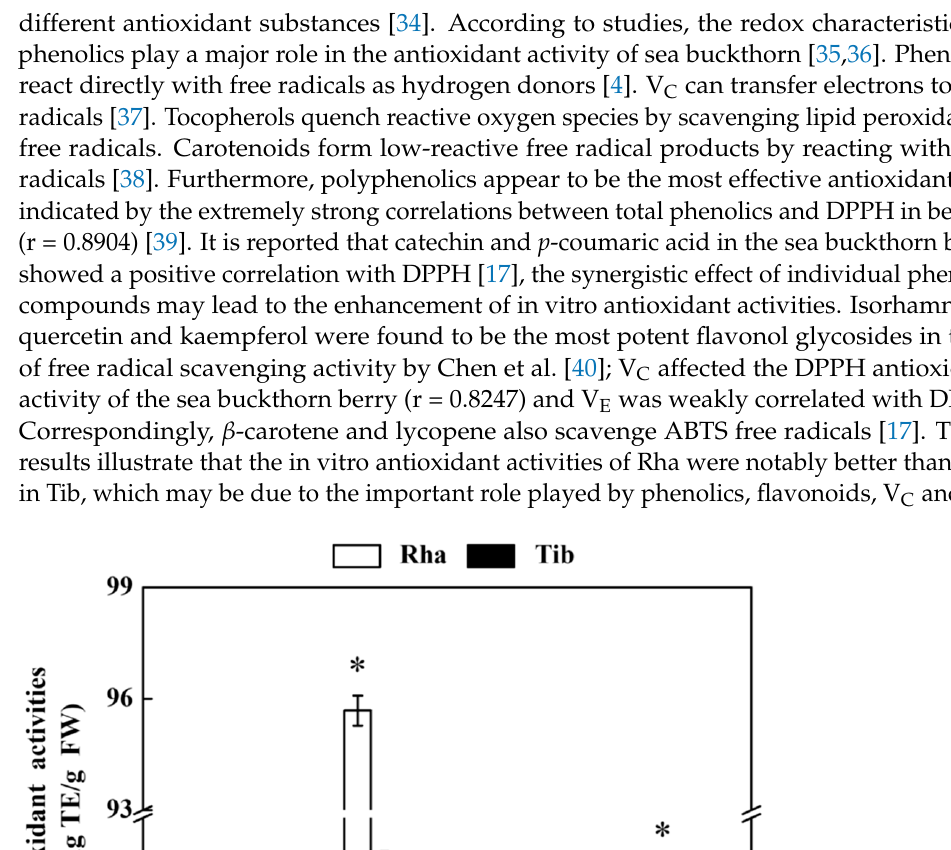
Figure 7. Cell viability ( A ) and CAA ( B ) of Rha and Tib berries. Vertical bars represent standard error of the mean (±SE), and the “*” indicate significant differences at p < 0.05. ( A ) Cell viability of Rha and Tib berries; ( B ) CAA of Rha and Tib berries. The CAA method is a reasonable method for assessing antioxidant activity based on cell culture models, reflecting the absorption and metabolism of antioxidants, and the re- sults have high biological relevance. Additionally, this method includes a ‘PBS wash’ method and a ‘no PBS wash’ method to evaluate the degree of uptake and membrane association of antioxidants [23]. When the cells were washed without PBS, the CAA values of Rha and Tib were 1915.38 μ mol QE/100 g FW and 1077.83 μ mol QE/100 g FW, respec- tively. When they were washed with PBS, the CAA values of Rha and Tib were 1210.56 μ mol QE/100 g FW and 866.20 μ mol QE/100 g FW, respectively (Figure 7B). Regardless of whether the cells were washed with PBS or not, the CAA value of Rha was always higher than that of Tib; this trend agrees with the in vitro antioxidant activity (DPPH, ABTS, FRAP) assay results. It further demonstrated that the antioxidant activity of the sea buck- thorn berry may be influenced by phenolics, flavonoids and V C . In general, the total